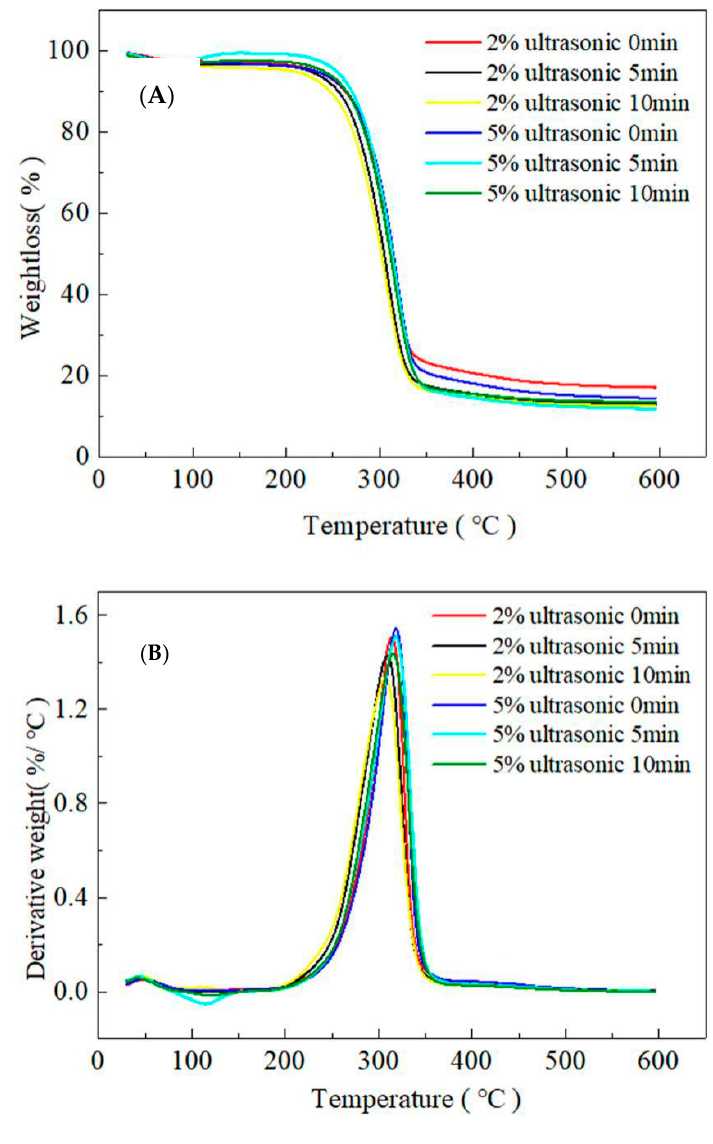
Figure 9. Thermogravimetric analyzer (TGA) ( A ) and DTG ( B ) for aerogel prepared at different conditions.